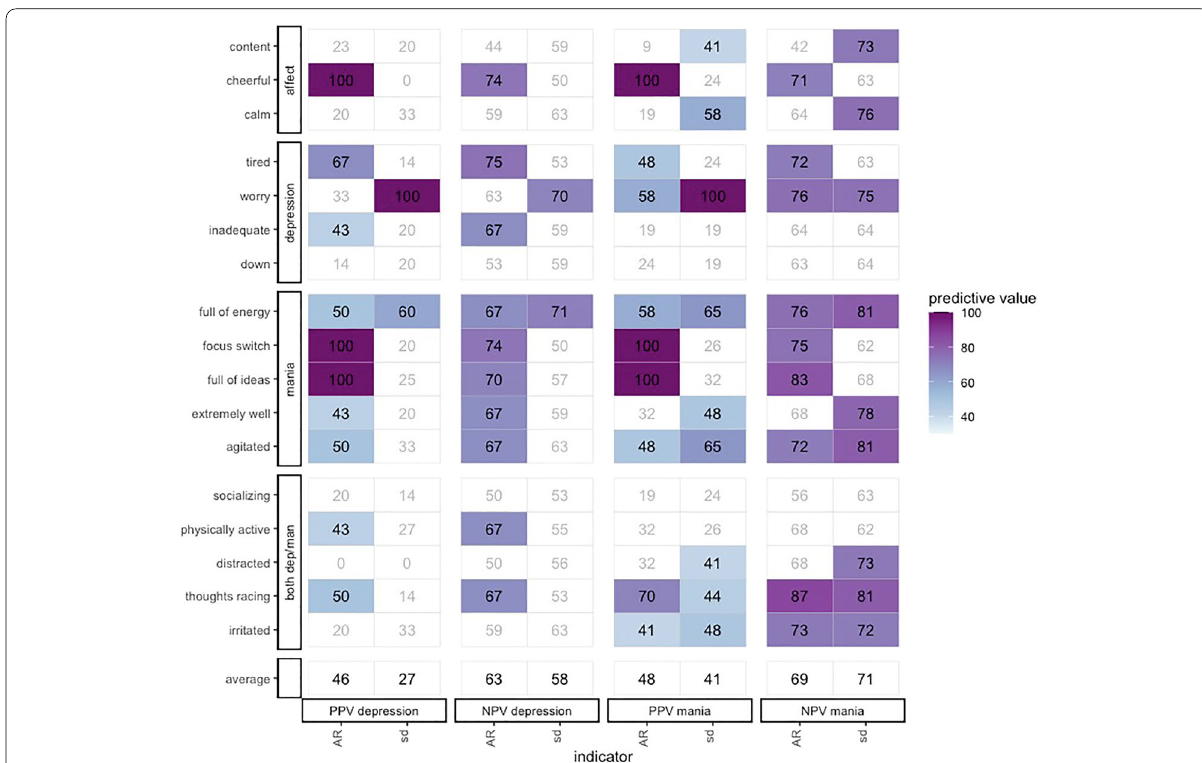
Fig. 3 Positive and negative predictive values for each early warning signal. The y-axis represents each momentary state, the x-axis the positive (PPV) and negative (NPV) predictive value, separated for manic and depressive transitions and for the two early warning signals (EWS) indicators: the autocorrelation (AR) and standard deviation (SD). The predictive values can be compared against the prevalence of the transition: the proportion of manic (32%), depressive (36%), or no transitions (68% for mania and 64% for depression). White tiles indicate that this EWS did not improve the detection of a transition above the prevalence of that transition. The color indicates the magnitude of the predictive value for that EWS: the more intense the color, the higher the predictive value. To facilitate interpretation, the EMA momentary states were assigned to summary categories based on hypothesized underlying